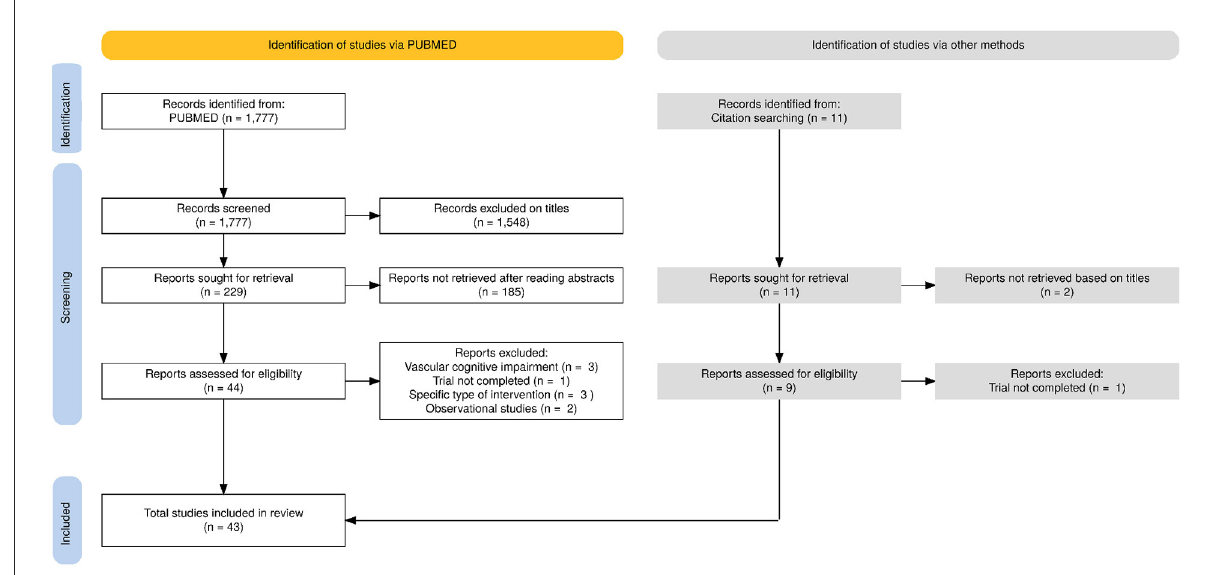
FIGURE1 PRISMA flowchart for the selection of the articles evaluated in this review.